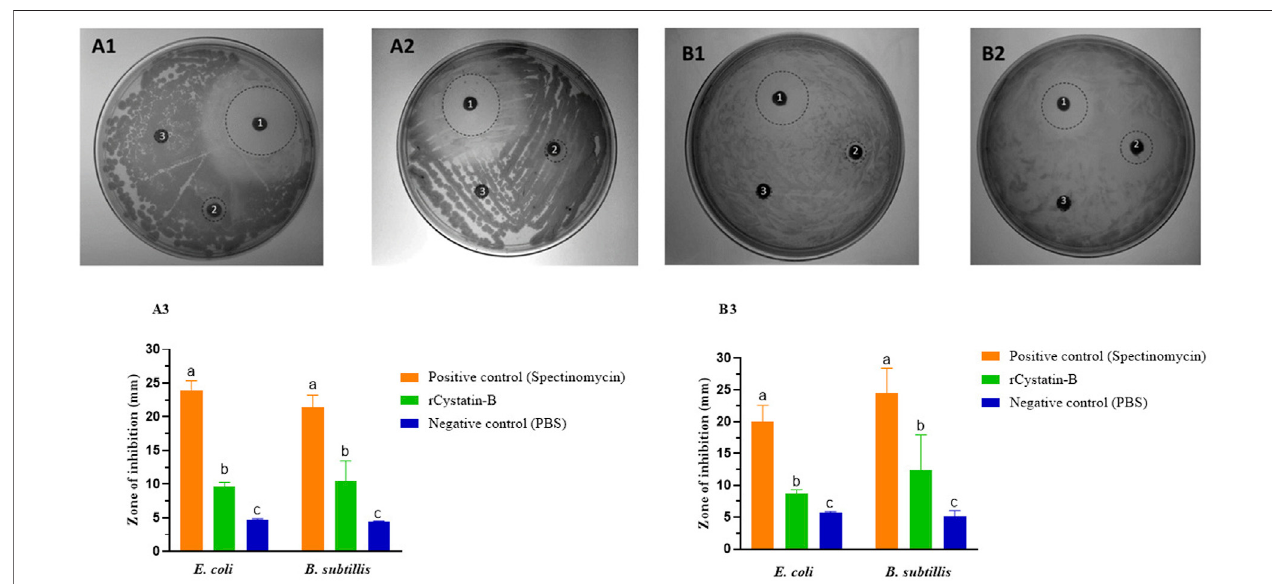
FIGURE 5 | Bacteriostatic action of rCystatin-B. ( A ). 60 μ g/ μ L. (A1). E. coli. (A2). B. subtilis . (A3). Zone of inhibition (diameter mm). ( B ). 80 µg/µL. (B1). E. coli . (B2) . B. subtilis . (B3). Inhibition diameter (mm). The dashed line circles correspond to the observed zone of inhibition. 1). Spectinomycin (positive control). 2) recombinant rCystatin-B protein. 3). PBS (negative control). Values are shown as mean ± standard deviation from the mean ( n = 3). Different letters show statistical differences ( p <